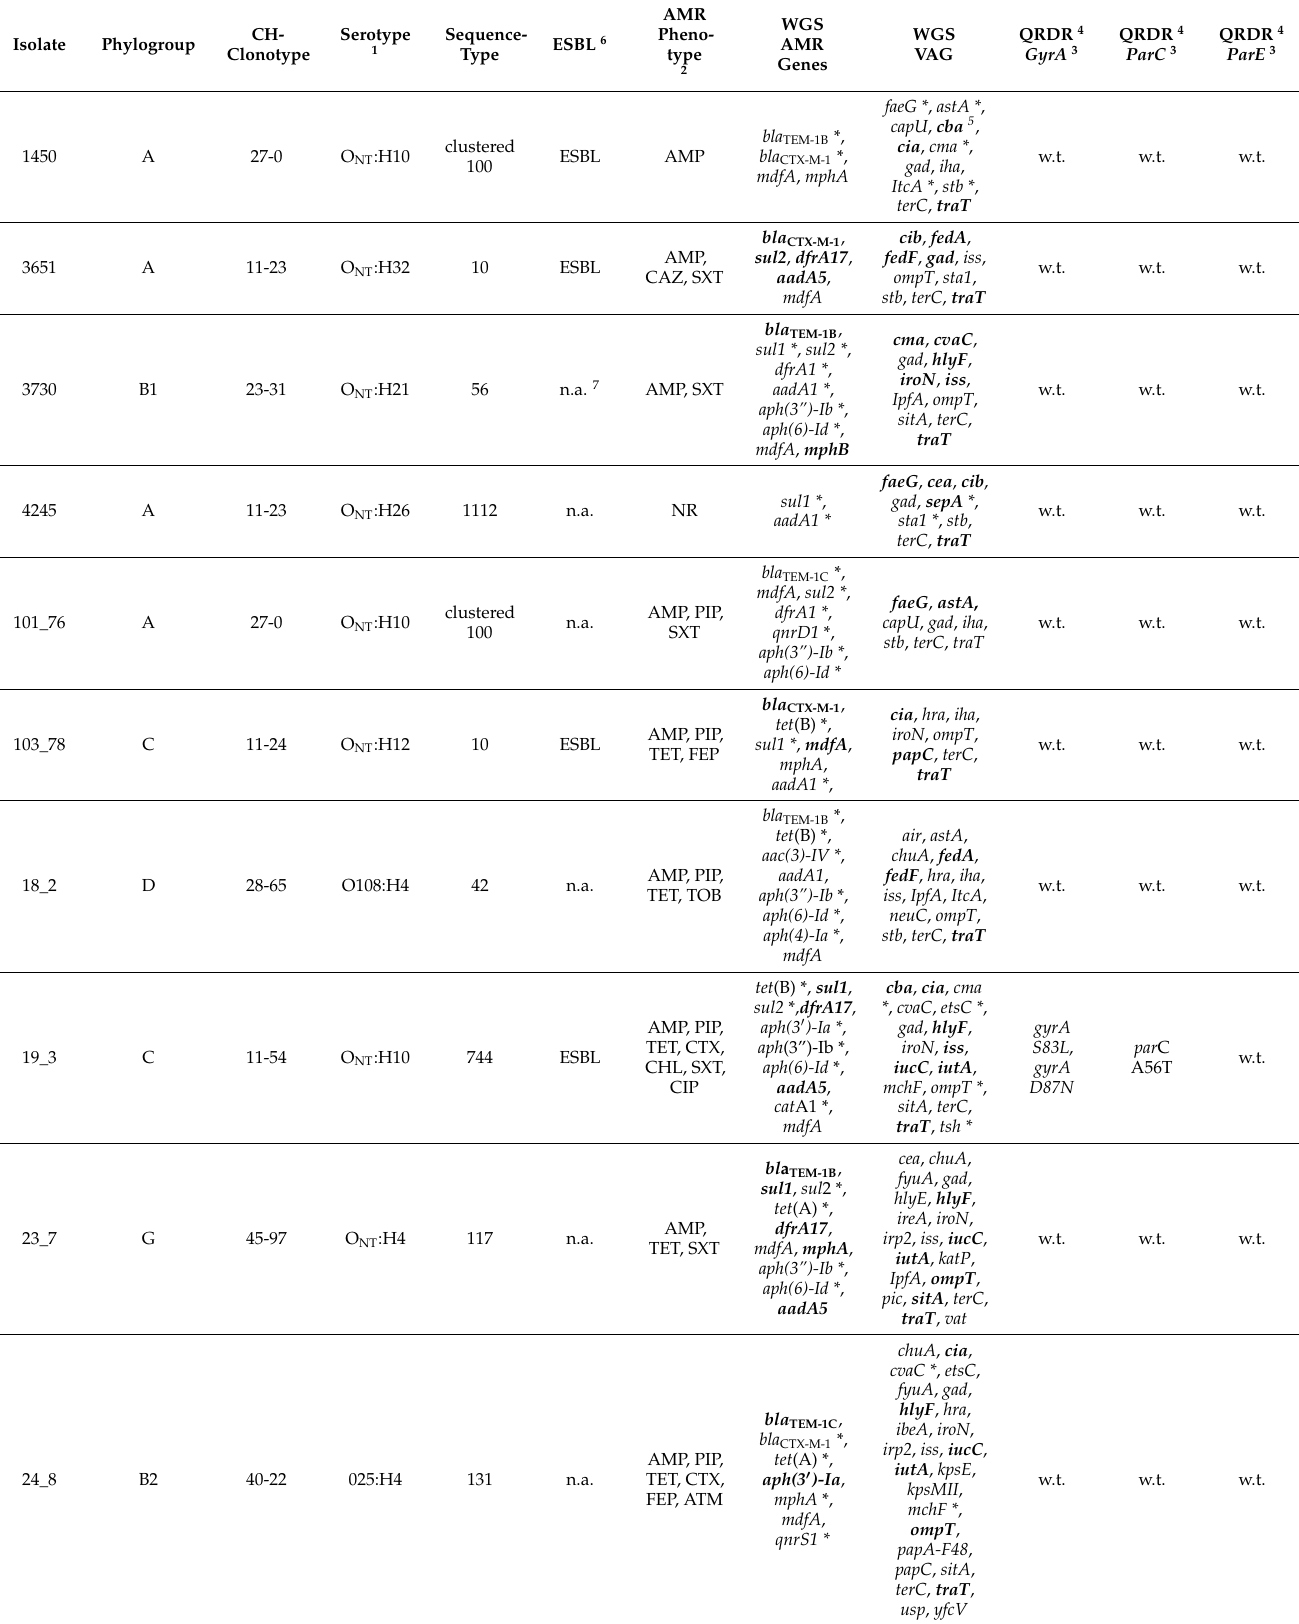
Table 2. Characterization of whole-genome-sequenced porcine E. coli